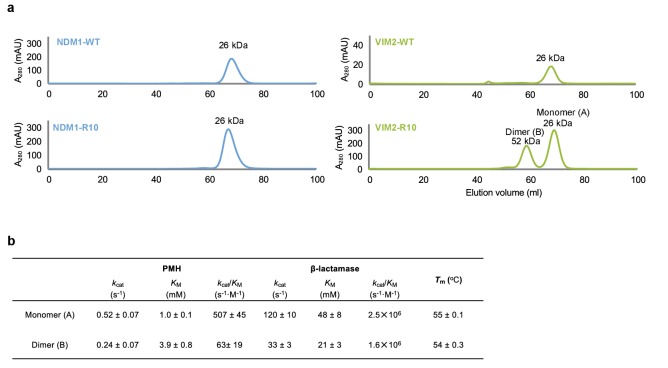
Oligomerization states of NDM1 and VIM2.(A) Size-exclusion chromatography (SEC) elution profile of NDM1-WT, NDM1-R10, VIM2-WT and VIM2-R10 (Superdex 75, GE Healthcare). Protein sizes were identified based on the calibration curve on the manufacturer’s instruction (GE Healthcare) for gel filtration calibration kits LMW (low molecular weight). VIM-R10 showed two peaks that correspond to monomeric and dimeric states. (B) Kinetic parameters and melting temperature (Tm) of monomer and dimer states of VIM2-R10.